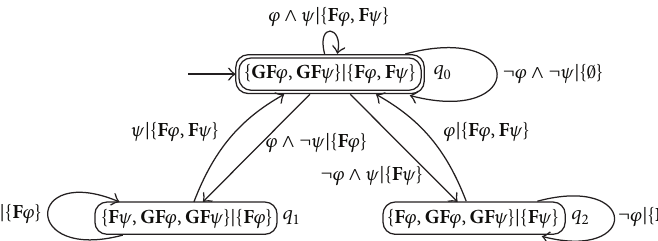
Figure 3: Building a BA corresponding to GF 𝜑 ∧ GF 𝜓 using on-the-fly